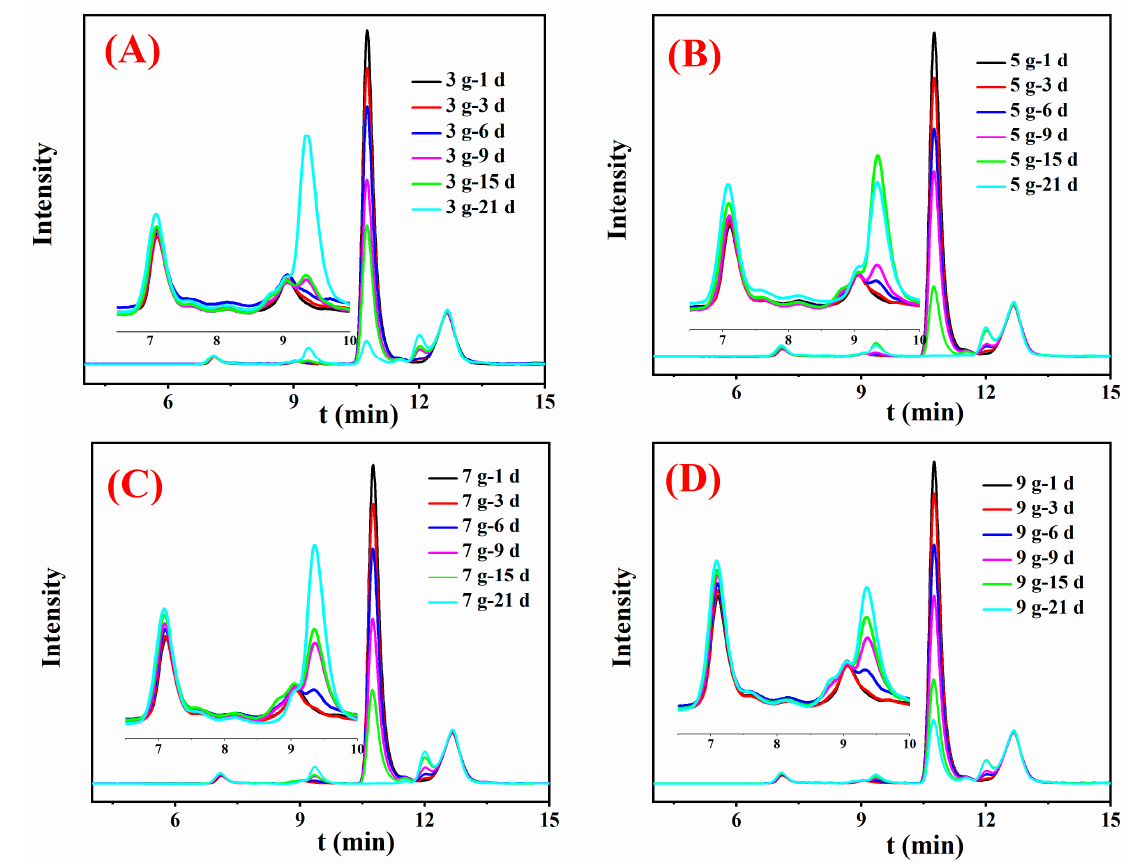
Figure 7. HPLC results for the medium supernatant with different contents of CCA-treated wood: CCA-treated wood of 3 g ( A ), CCA-treated wood of 5 g ( B ), CCA-treated wood of 7 g ( C ), and CCA- treated wood of 9 g ( D ).